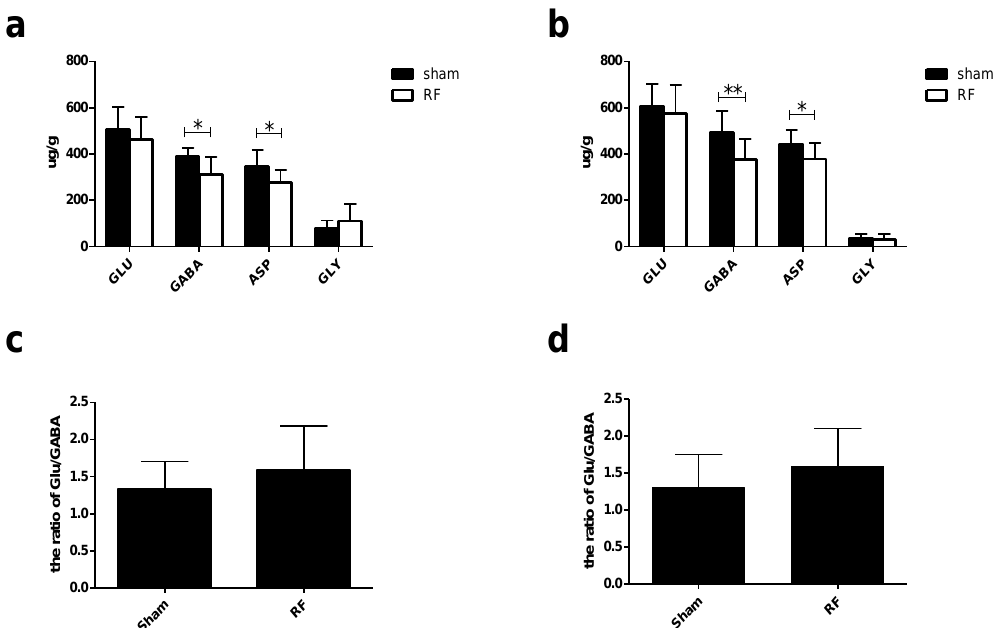
Figure 8. Effects of RF exposure on the levels of four amino acid neurotransmitters in hippocampus and cortex. ( a ) hippocampus (Glu: t = 0.915, df = 16, P = 0.374; GABA: t = 2.673, df = 16, P = 0.017; ASP: t = 2.266, df = 16, P = 0.038; Gly: t = 1.132, df = 16, P = 0.275), ( b ) cortex (Glu: t = 0.659, df = 18, P = 0.518; GABA: t = 2.939, df = 18, P = 0.009; ASP: t = 2.173, df = 18, P = 0.043; Gly: t = 0.889, df = 17, P = 0.386), ( c ) the ratio of Glu/GABA in hippocampus (t = 1.146, df = 16, P = 0.269), (d) the ratio of Glu/GABA in cortex (t = 1.342, df = 18, P = 0.196). The data are presented as mean ± SD, * P < 0.05, ** P < 0.01, compared with the sham group.